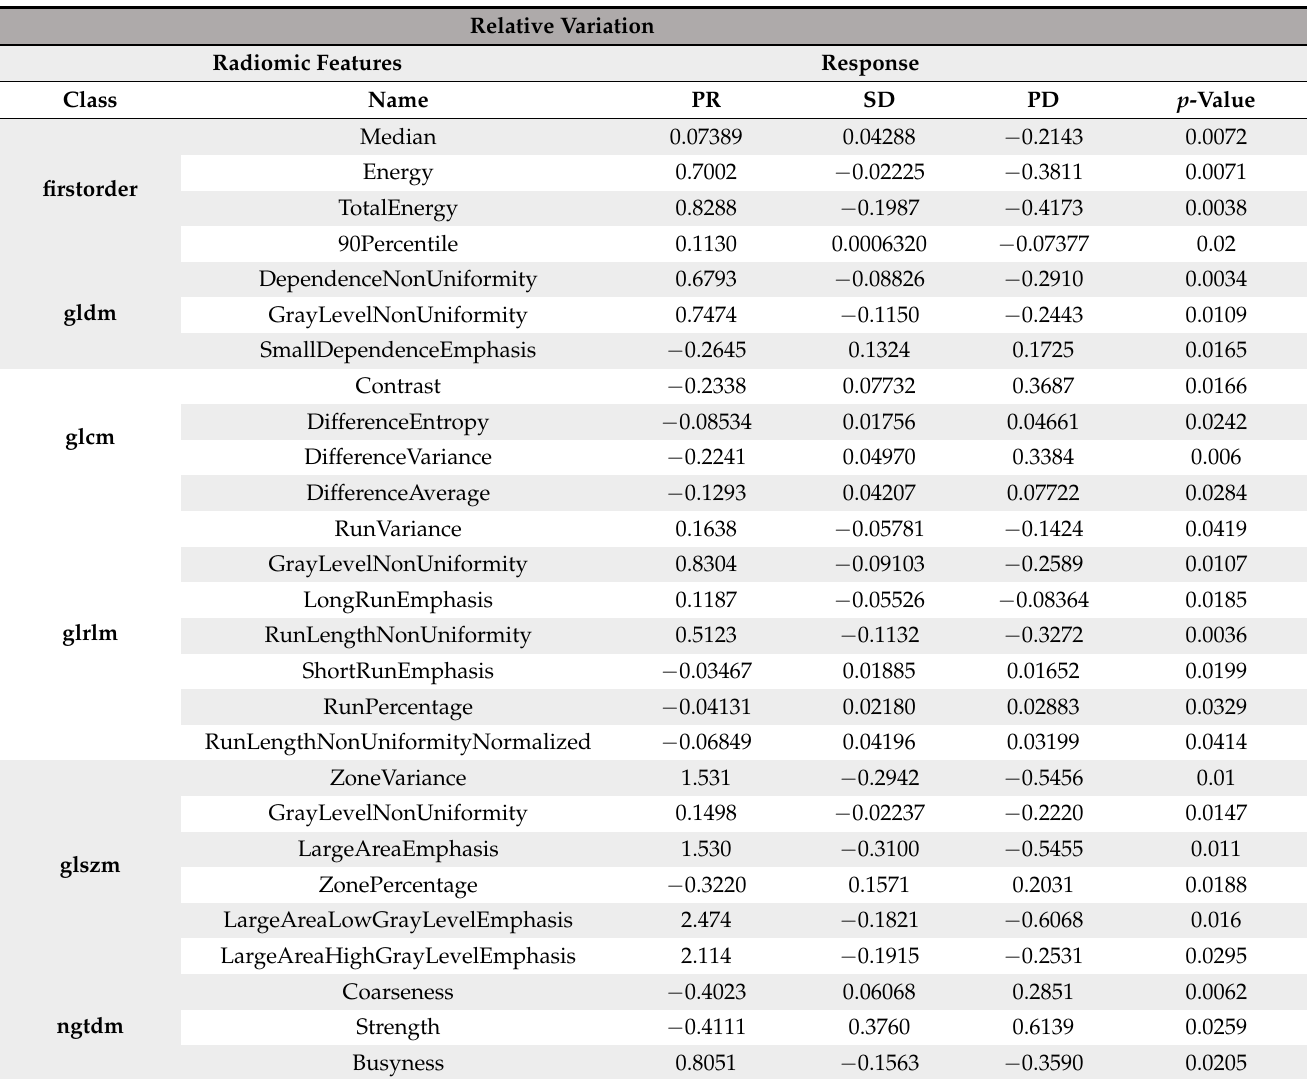
Table 1. Delta-radiomic features were calculated with the RV method that resulted statistically different in the three response classes. The results are presented as median values for each class and p